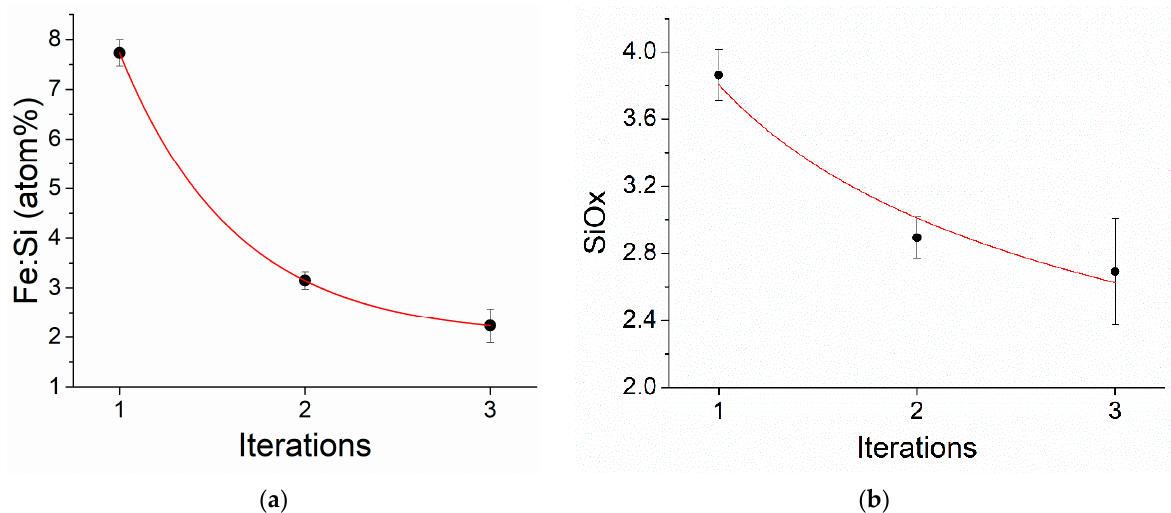
Figure 6. ( a ) Fe:Si ratio and ( b ) Si:O ratio with a variation in the number of iterations.